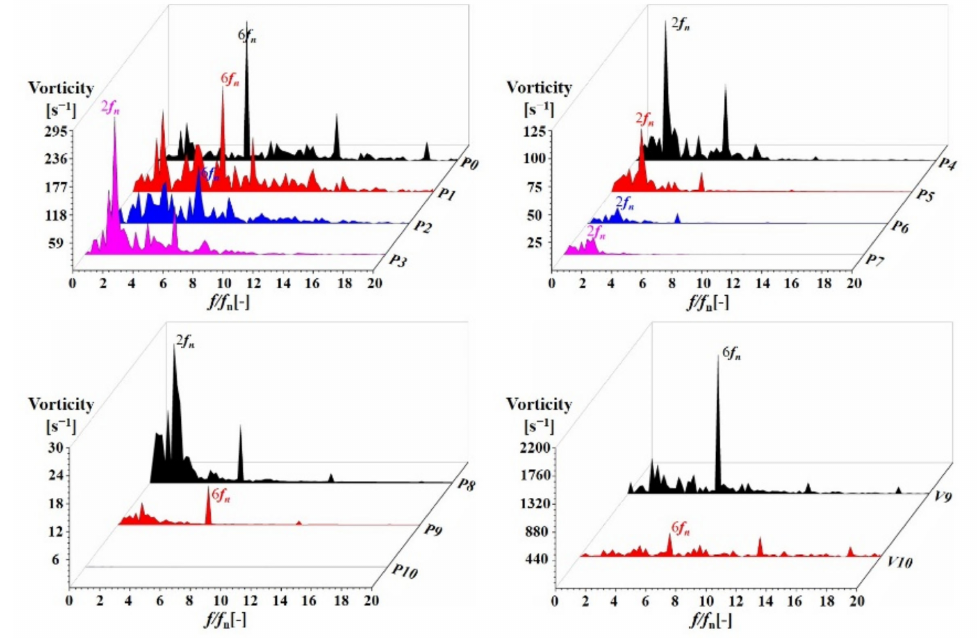
Figure 13. Frequency domain of vorticity fluctuation at the Q b operation